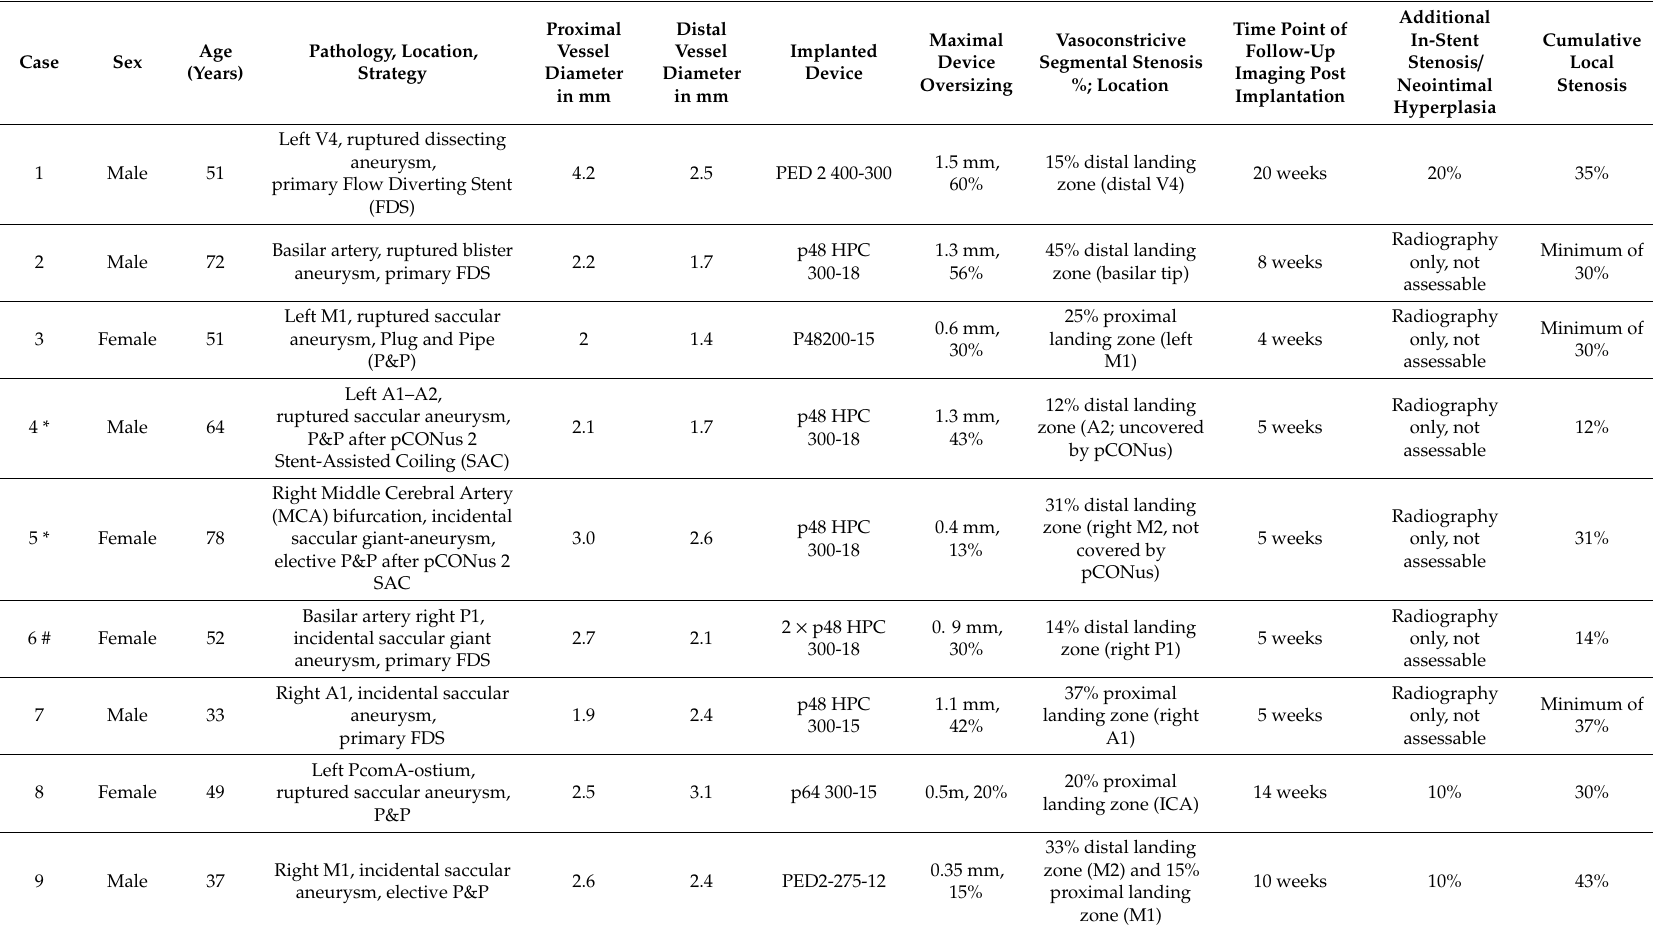
Table 1. Summary of clinical and technical features of all included